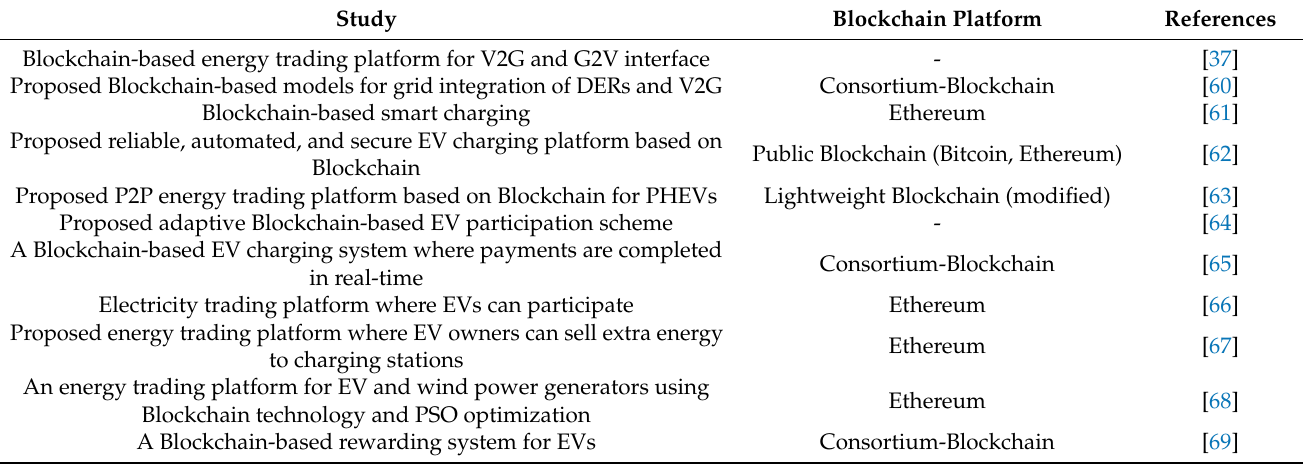
Table 5. Summary of publications employing Blockchain technology for EV